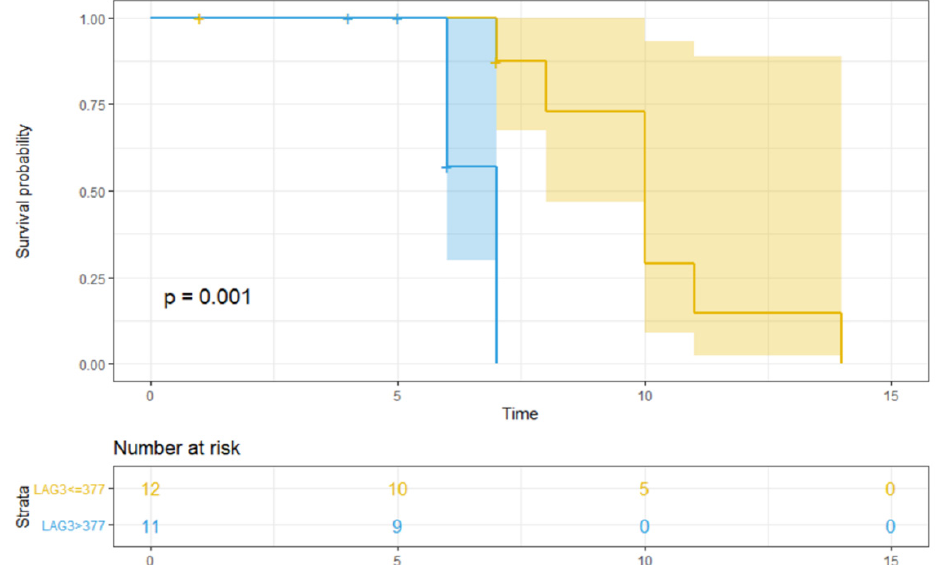
Figure 3. The OS over time according to baseline sLAG3 value. Figure 3 shows the OS over time (expressed in months after the start of treatment) in patients with/without an LAG3 value higher than the median. The number of patients at risk is also indicated. OS refers to overall survival; 377 is the median value of LAG3, expressed in pg/mL; the blue line represents OS in patients with sLAG3 > 377 pg/mL, and the yellow line represents OS in patients with sLAG3 ≤ 377 pg/mL; the shaded bands represent the confidence intervals at each time point. The table under the figure indicates the number of subjects in each group (i.e., sLAG3 > 377 or ≤ 377 pg/mL) at baseline (0) or at 5, 10, or 15 months after the beginning of treatment. p = p-value; significant p-values are indicated in bold.